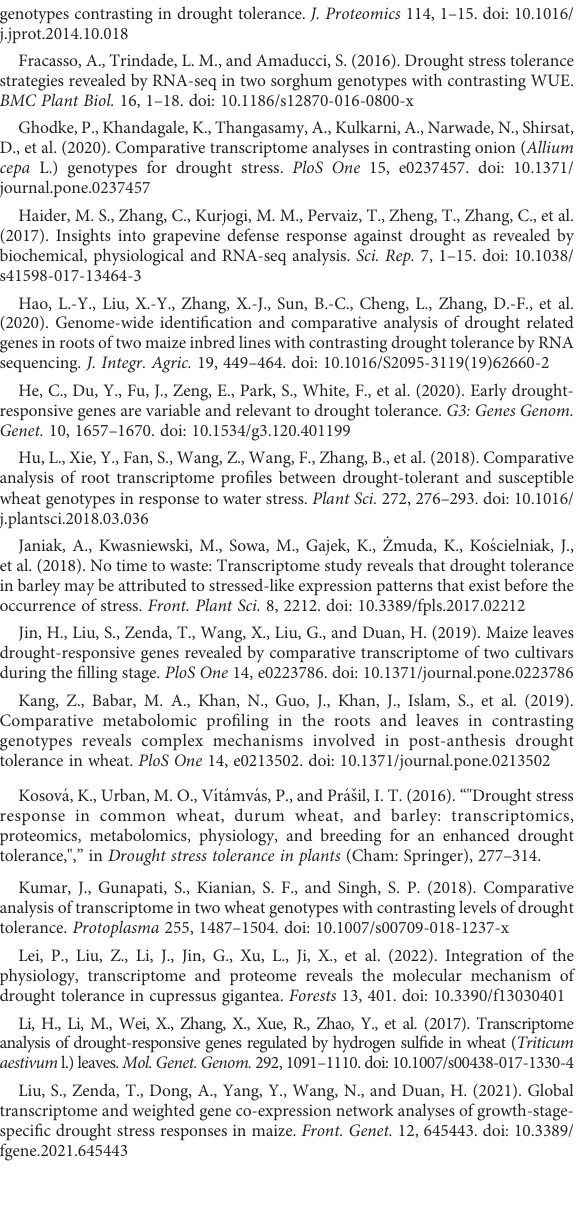
SUPPLEMENTARY FIGURE 4 Differently expressed genes displayed as Bars graph in different groups two bars showed gene expression one having a higher number of transcripts and other with